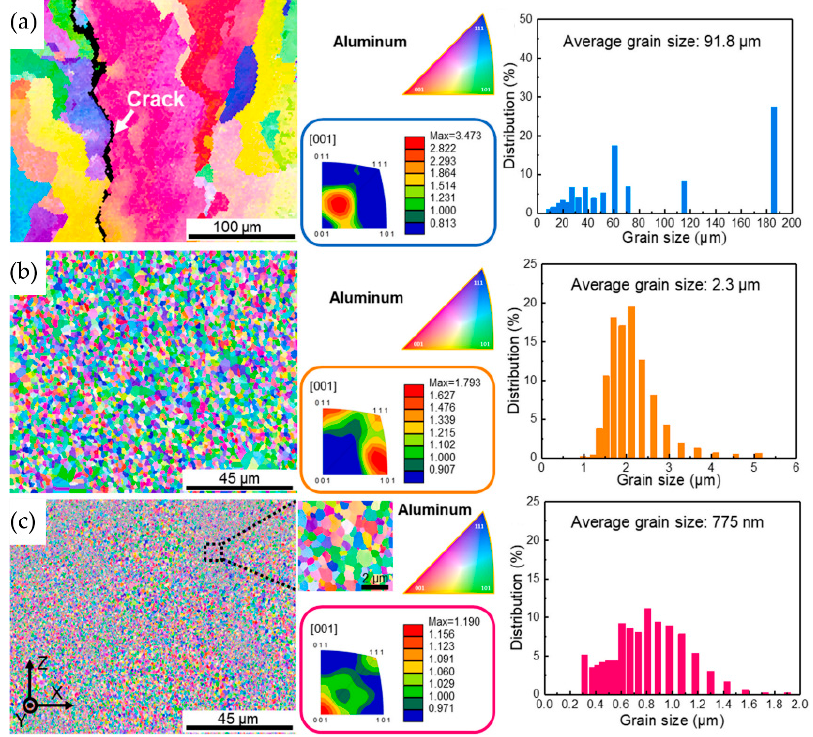
Figure 14. EBSD maps of the LPBF ‐ printed AA7075 Al alloy: ( a ) Pure AA7050; ( b ) 7050 ‐ 1.82 wt.%Ti; ( c ) 7050 ‐ 2 wt%Ti/TiN. Reproduced with permission from Elsevier